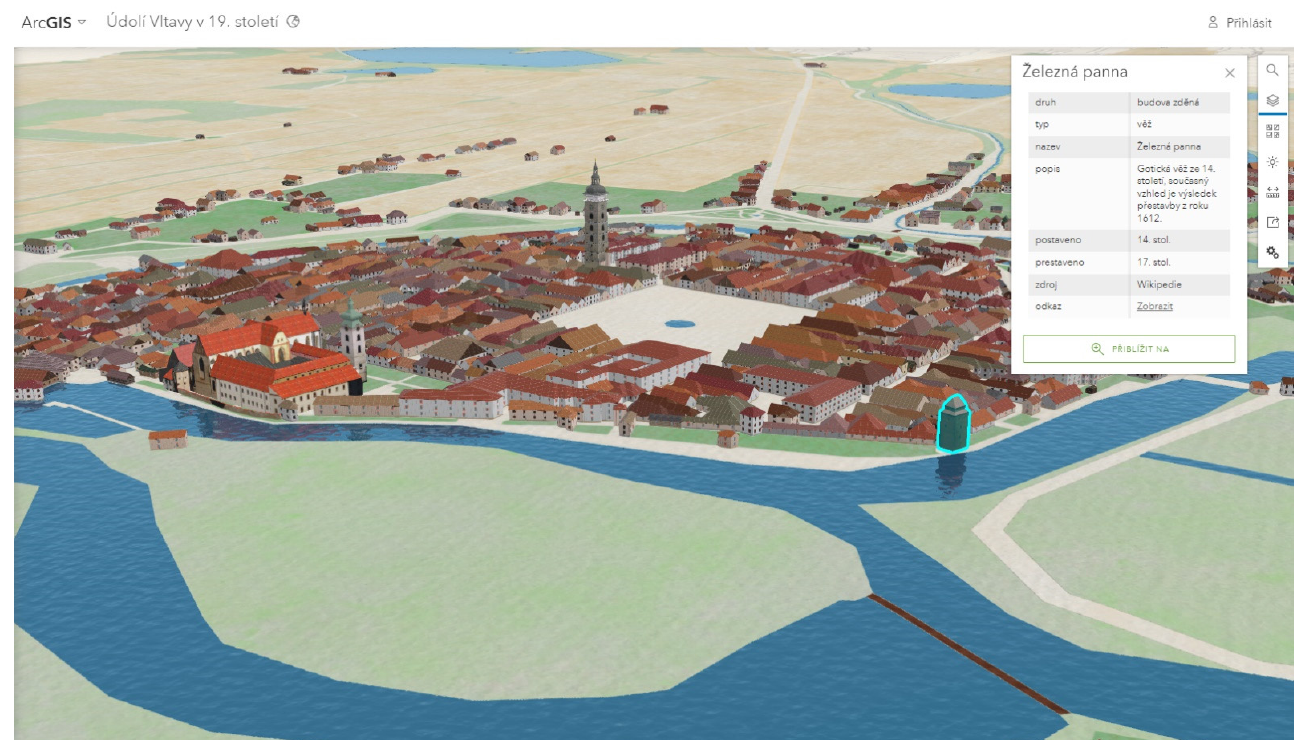
Figure 18. Preview of a part of the resulting 3D web scene—the city of Č eské Bud ě jovice on the banks of the Vltava River in the 19th century. The fortification tower was identified to access its attribute information. The modelling of the city was based on Imperial Obligatory Imprints of the Stable Cadastre 1:2880 and period plans and